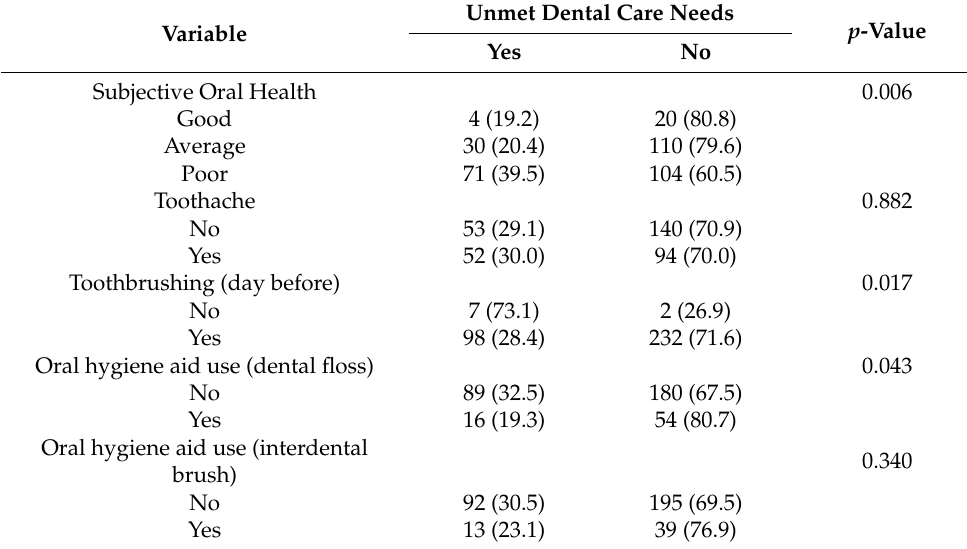
Table 2. Unmet dental care needs according to the oral health-related characteristics of cancer